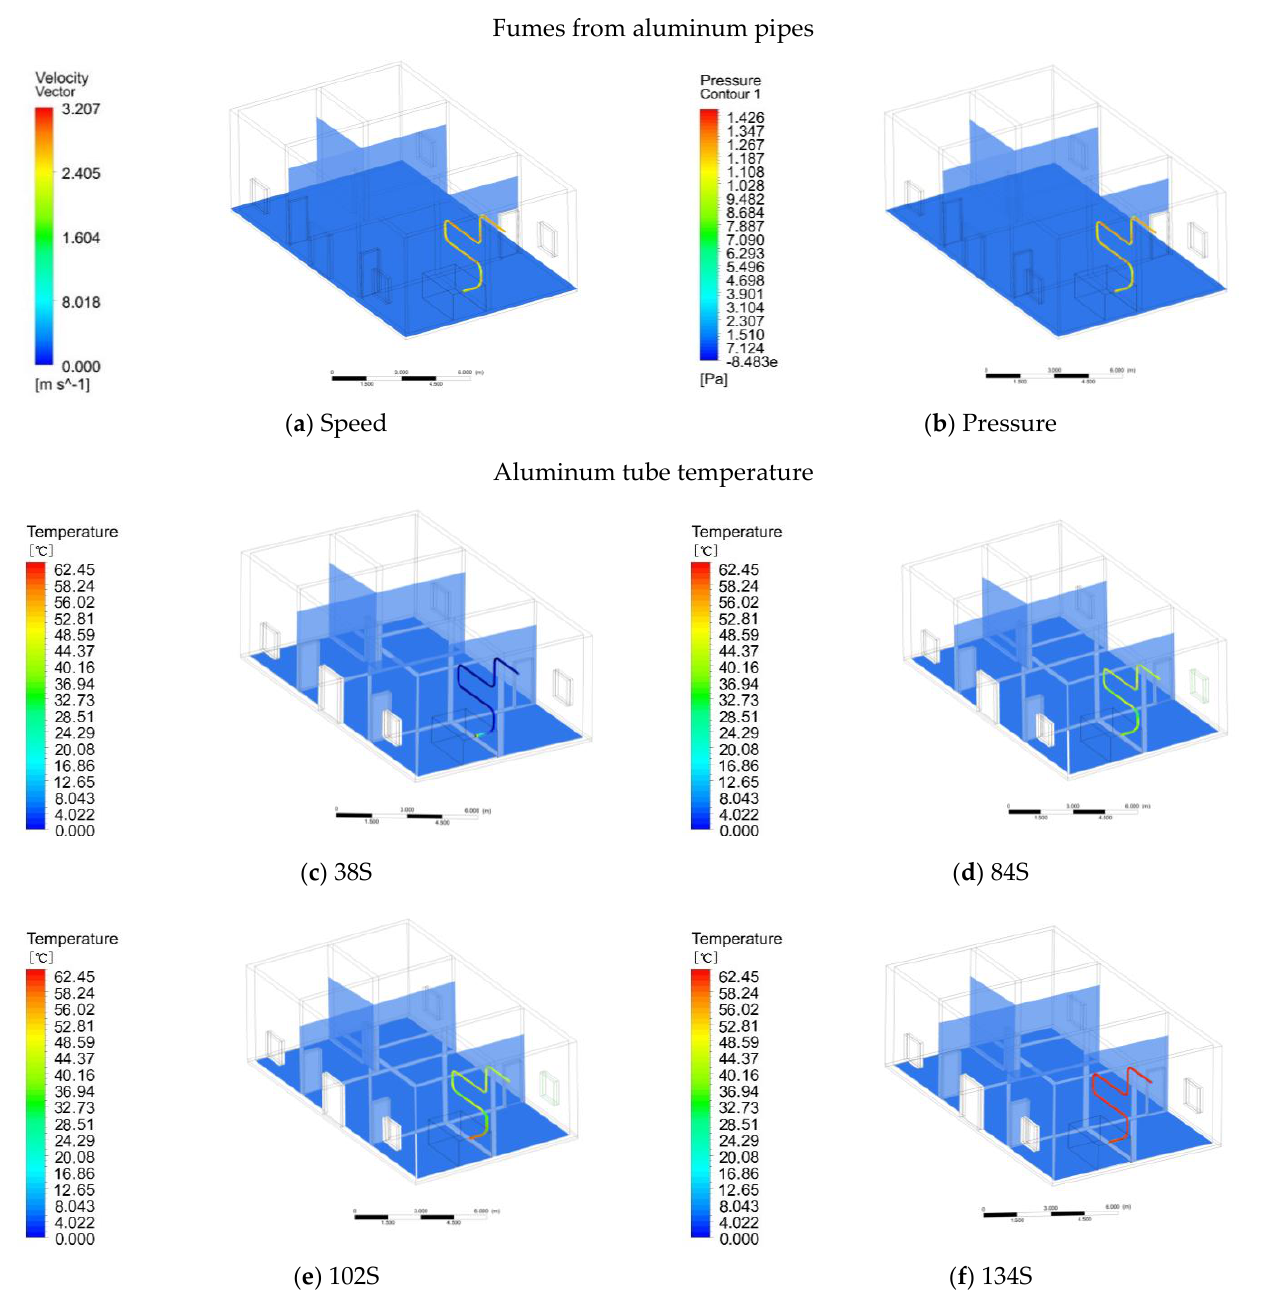
Figure 9. ( a ) Flue gas velocity in aluminum tube; ( b ) Flue gas pressure in aluminum pipe; ( c ) The temperature of 38-s aluminum tube; ( d ) The temperature of 84-s aluminum tube; ( e ) The temperature of 102-s aluminum tube; ( f ) The temperature of 134-s aluminum tube.